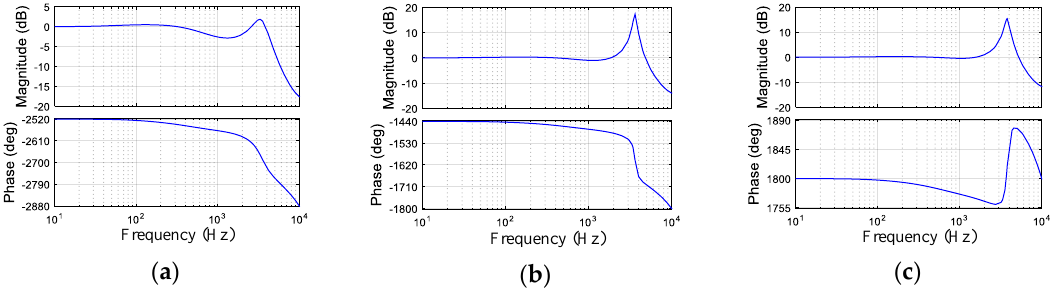
Figure 13. Bode diagrams of voltage closed-loop transfer function: ( a ) K vp = 0.3; ( b ) K vp = 0.5; ( c ) K vp = 0.7.